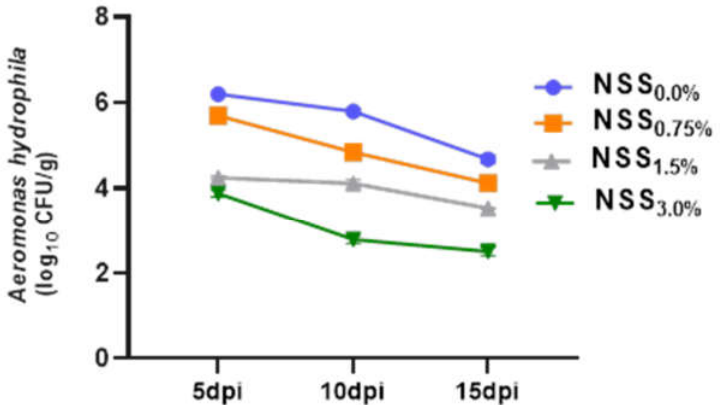
Figure 4. Effect of supplementing diets with varying levels of a microalgae mix (NSS) containing Nannochloropsis oculate and Schizochytrium and Spirulina species at equal proportions (1:1:1) for 12 weeks on the population of Aeromonas hydrophila at 5, 10, and 15 days post-infection (dpi). Data are expressed as means ± SE. Bars with different letters denote significant differences ( p < 0.05). NSS: microalgae mix containing Nannochloropsis oculate and Schizochytrium and Spirulina species at equal proportions (1:1:1), NSS 0.0% : control group fed basal diet free from NSS, NSS 0.75% : basal diet supplemented with 0.75% of NSS, NSS 1.5% : basal diet supplemented with 1.5% of NSS, NSS 3.0% : basal diet supplemented with 3% of NSS.